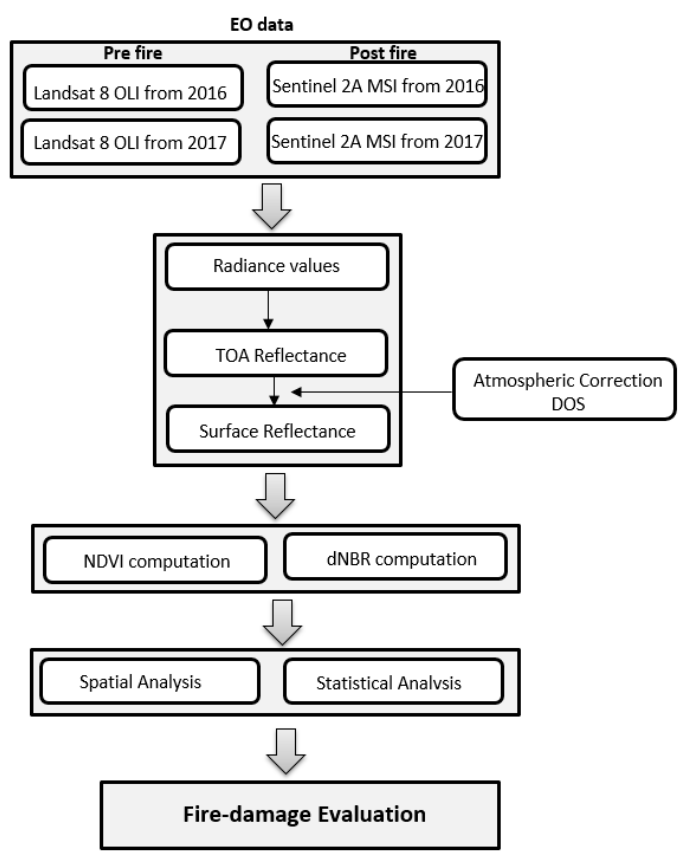
Figure 2. Flowchart of the methodology followed in this work.